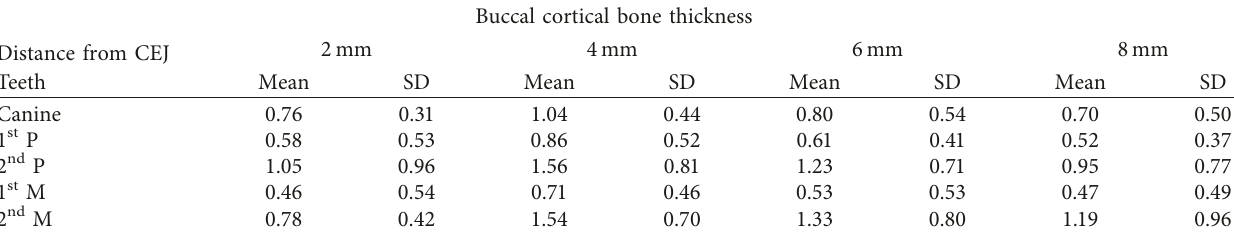
Table 2: Buccal cortical bone thickness in millimeter.